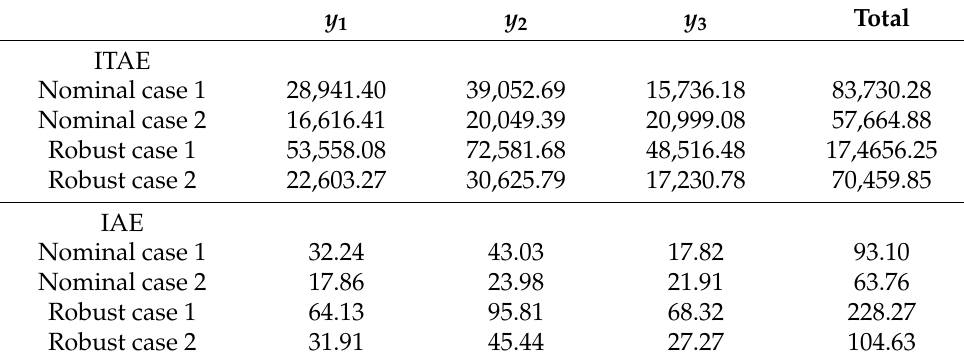
Table 2. Performance indices for the Shell Heavy Oil